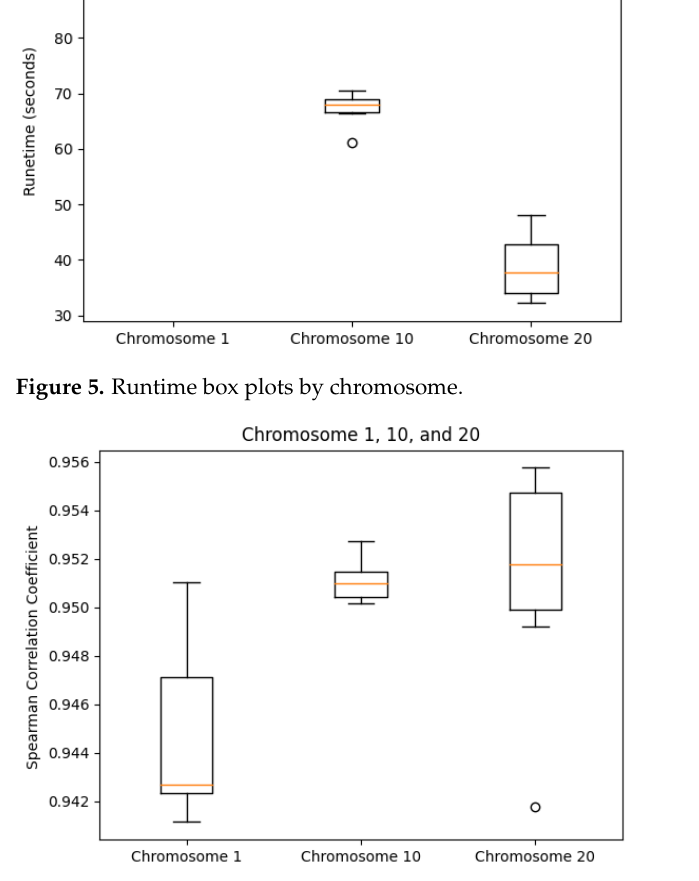
Figure 6. SCC box plots by chromosome.